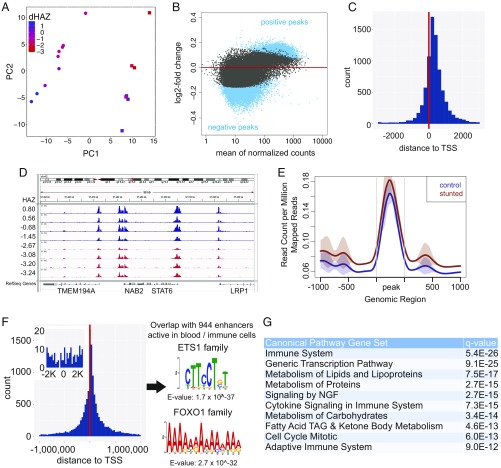
Differential H3K4me3 signature correlated with ΔHAZ (growth trajectory) at 1 y of age. (A) PC analysis plot of H3K4me3 datasets from 1-y-old children (with 47% and 19.8% of the variance in the data explained by PC1 and PC2, respectively). Each dot represents a child’s dataset. Data point color corresponds to the child’s ∆HAZ score, as indicated on the scale bar. Circles indicate girls, squares indicate boys. (B) Normalized mean H3K4me3 signal is plotted versus the log2 fold-change per unit of ∆HAZ score in data from 1-y-old children. Each dot represents a peak; blue dots have FDR-corrected P < 0.05. (C) Distribution with respect to the TSS of H3K4me3 peaks positively correlated with ΔHAZ score. Approximately 62% of the significantly affected peaks are within 2 kb of the TSS. (D) Genome browser screenshot showing H3K4me3 read distributions (normalized to total read count) in four control (blue) and four stunted (red) individuals at 1 y of age. Datasets were selected to represent the range in HAZ scores, as indicated. Note that peaks in stunted children tend to be smaller than peaks in control children. (E) Average plots of histone H3K4me3 levels at peaks negatively correlated with ΔHAZ score in control and stunted children. Stunted children were phenotypically defined, as in Fig. 2A. (F) Distribution with respect to the TSS of H3K4me3 peaks negatively correlated with the ΔHAZ score. Approximately 0.8% of the significantly affected peaks are within 2 kb of the TSS (Inset). Peaks in this set overlapped with 944 enhancers active in blood/immune cells. Motifs identified with these enhancers are shown by the logos, with E-values for their occurrence shown below each one. The motifs show statistically significant similarity to sites bound by ETS1 family and FOXO1 family transcription factors. (G) Top 10 reactome canonical pathways significantly associated with genes with H3K4me3 peaks positively correlated with ΔHAZ score identified with MSigDB. TAG, triacylglycerol. FDR-corrected q-value is shown.